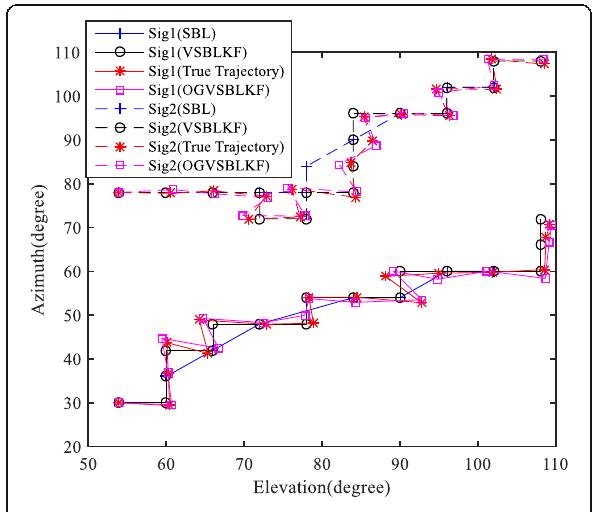
Fig. 15 Traces of three methods for two signals